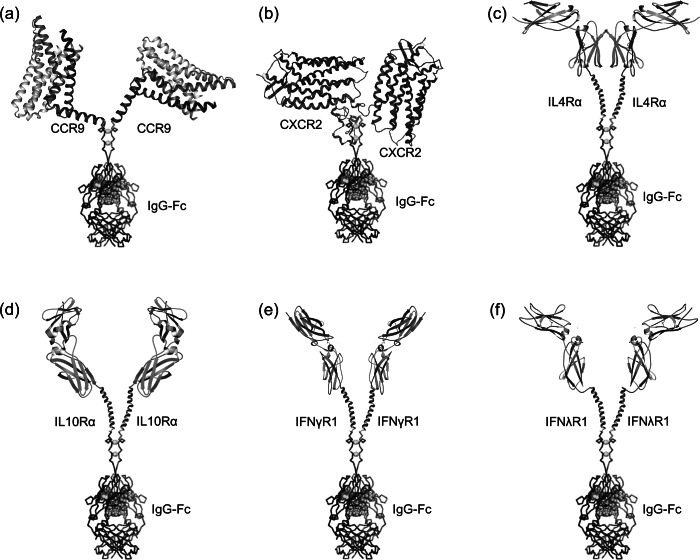
Schematic illustration for Fc-fused QTY variant cytokine receptors with antibody-like structure. (a) CCR9QTY–Fc; (b) CXCR2QTY–Fc; (c) IL4RαQTY–Fc; (d) IL10RαQTY–Fc; (e) IFNγR1QTY–Fc; (f) IFNλR1QTY–Fc. These illustrations are not to scale and the receptors parts are significantly emphasized for clarity.